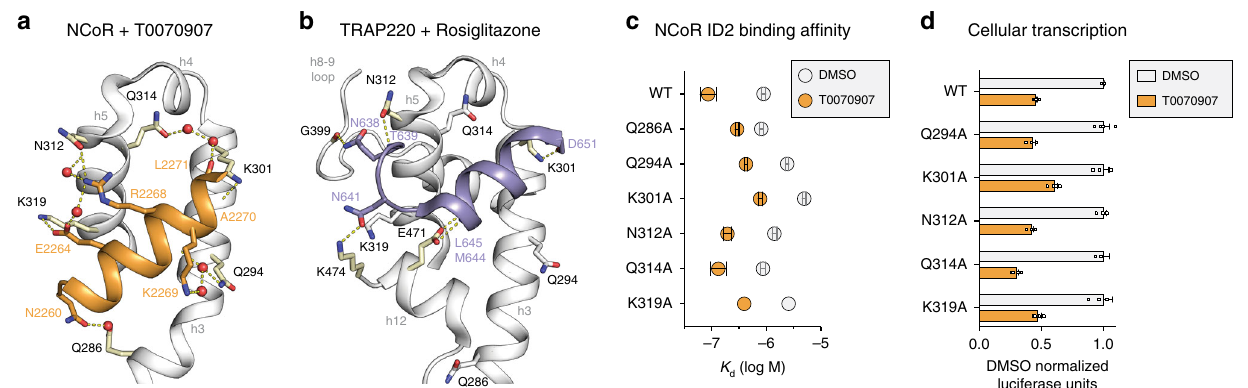
Fig. 5 Comparison of the corepressor and coactivator interaction network. a Interactions with six residues in the PPAR γ AF-2 surface mediate binding to the helical core of the NCoR ID2 peptide (PDB 6ONI). b Fewer interactions mediate binding to the helical core of the TRAP220 coactivator peptide (PDB 6ONJ). c NCoR ID2 peptide af fi nities and errors (mean ± s.d. of the fi t to a one site — total binding equation) from fl uorescence polarization peptide interaction assays using structure-guided mutants (Supplementary Fig. 4) displayed to illustrate the difference in NCoR ID2 peptide binding af fi nity between apo- and T0070907-bound PPAR γ LBD. d Cell-based luciferase reporter assay in HEK293T cells treated with DMSO control or 5 μ M T0070907 measuring the ligand-dependent change in wild-type or mutant PPAR γ transcription; data normalized to each WT or mutant construct vehicle control (DMSO) condition ( n = 4; mean ± s.e.m.). Source data are provided as a Source Data fi